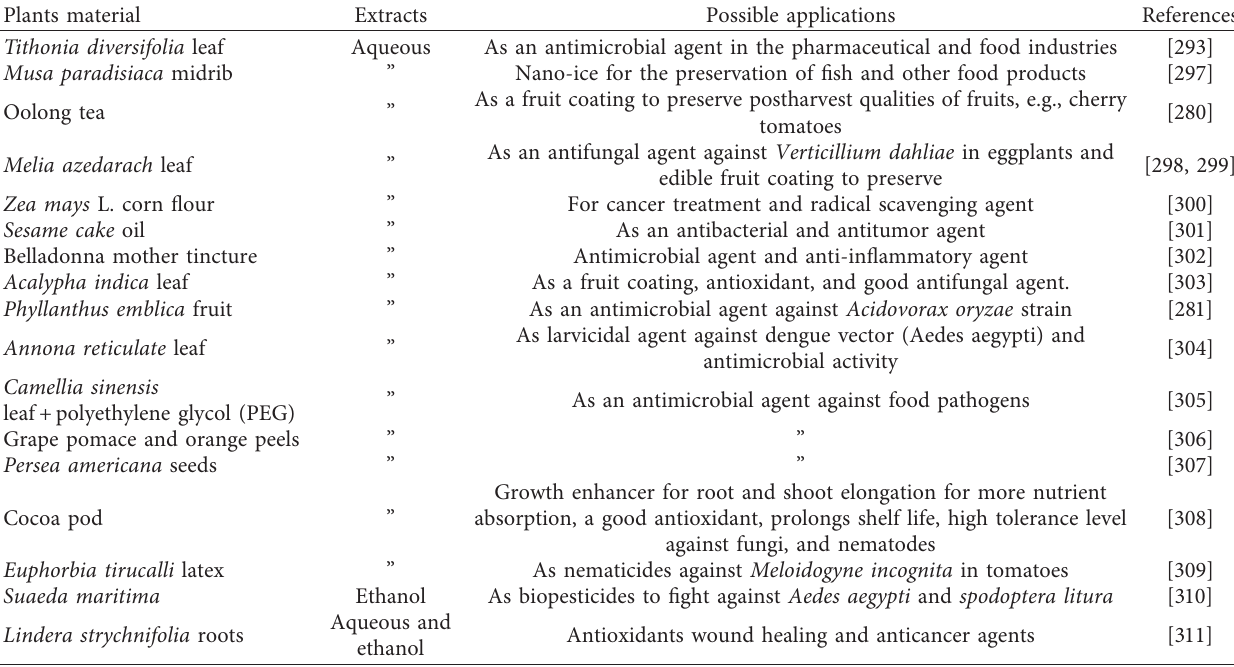
Table 4: Green synthesized silver nanoparticles from plant and their applications in crop protection and food preservation. Plants